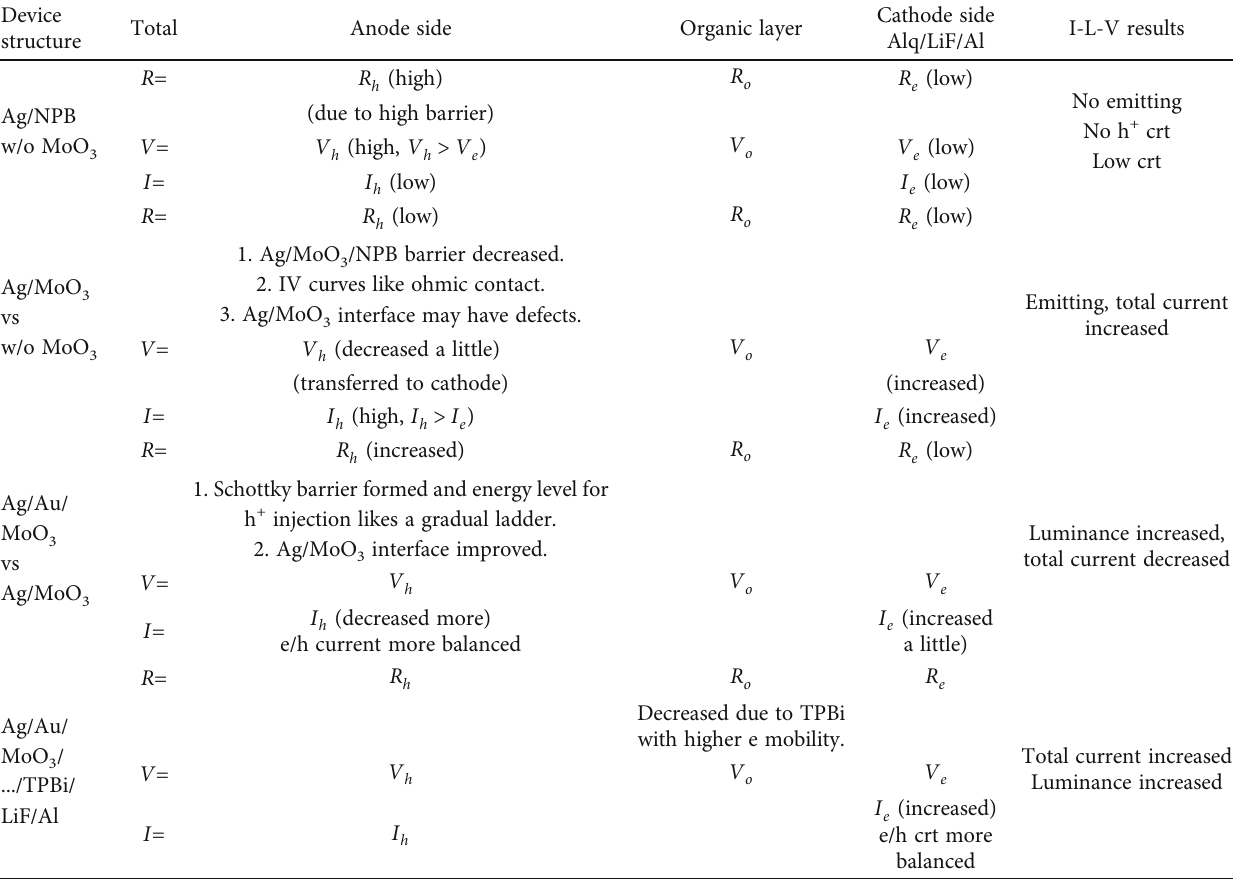
Figure 9: The characteristic curves of (a) current density-luminance-voltage and (b) current e ffi cient-voltage of TE-OLED in the anode Ag/ structure. Au/MoO 3 Table 4: A detailed discussion of resistance, voltage, and current of anode side, an organic layer, and cathode side, respectively, in TE-